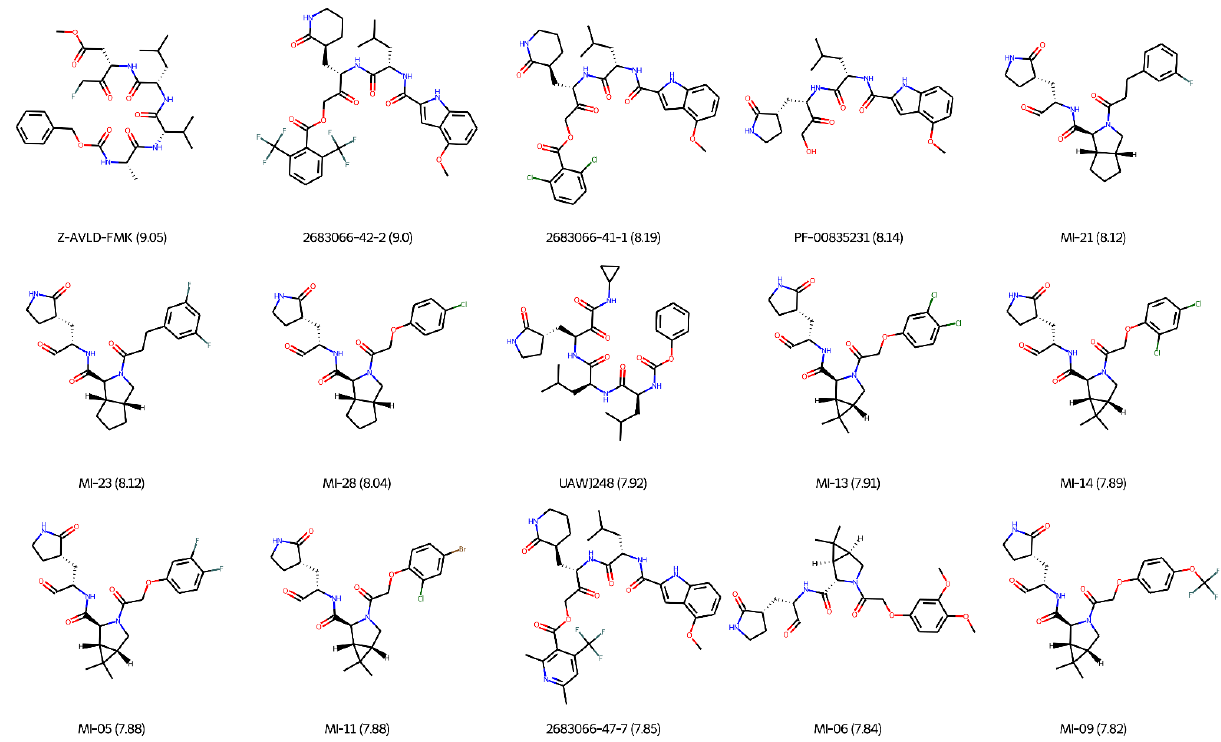
Figure 8. The 15 most potent covalent inhibitors of the SARS-CoV-2 M-pro. Only M-pro inhibitors with pIC 50 values that can inhibit the SARS-CoV-2 replication in a cellular antiviral assay are shown. pIC 50 values are shown in parentheses.